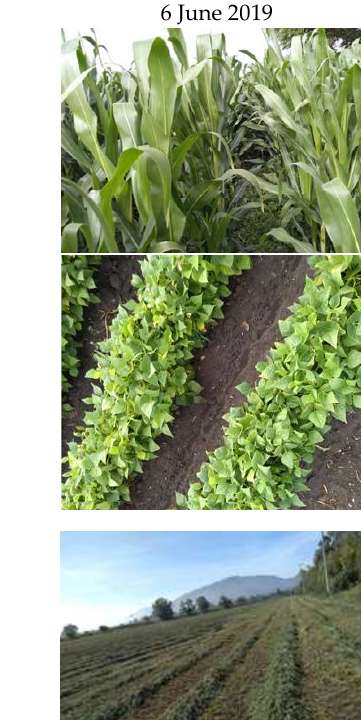
Figure 8. Differences in the sowing date of the same crop (corn). Another limitation of the proposed method is that it will not always be possible to have a series of continuous satellite images free of clouds. If a continuous series of cloud-free images is not available, it is difficult to form a homogeneous time series. Due to the presence of clouds in some images during the agri- cultural cycle, forming time series every 5 or 10 days to cover the entire cycle was impos- sible. However, it was possible to form time series every 15 or 30 days. Under these conditions and considering that it will not always be possible to form the same combinations in other years or in other areas, four combinations were chosen to determine the smallest number of images necessary to generate classification models. The combinations used are shown in Table 4. Combinations C1 and C3 use three scenes and